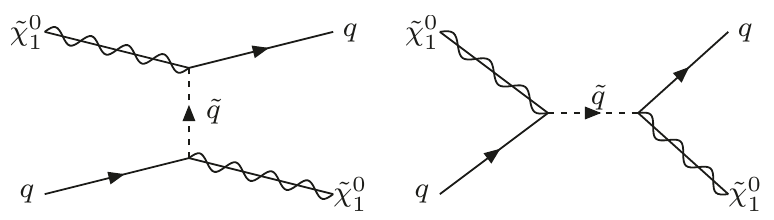
Figure 8. Tree level diagrams for the DM